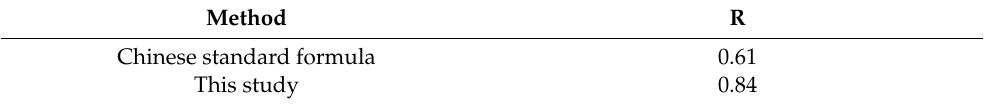
Table 2. Comparison of the evaluation index between our model and the Chinese standard